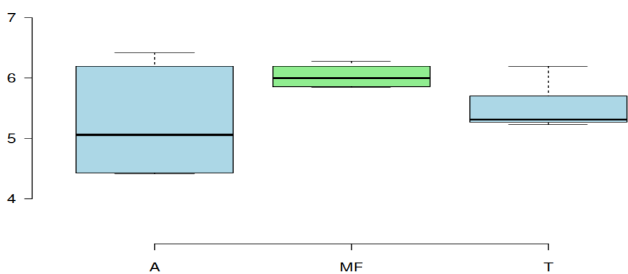
Figure 4. Box plot for RMSE in single-parameter subset performance.